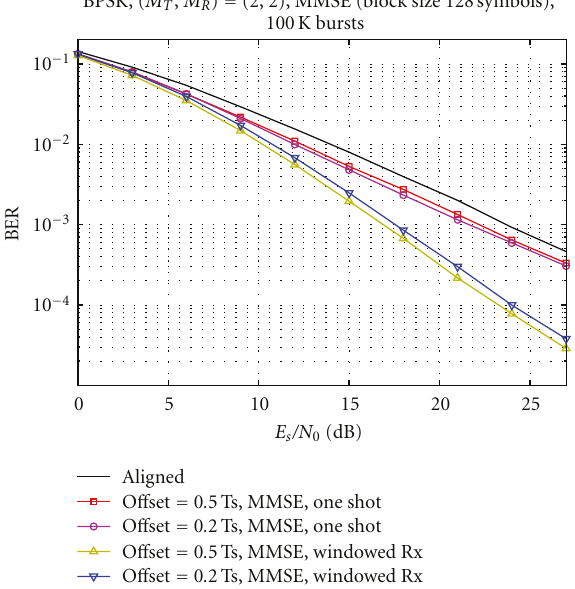
Figure 10: O ff set MIMO with MMSE Rx compared OSIC VBLAST, ( M T , M R ) = (2,2), modulation = QPSK.